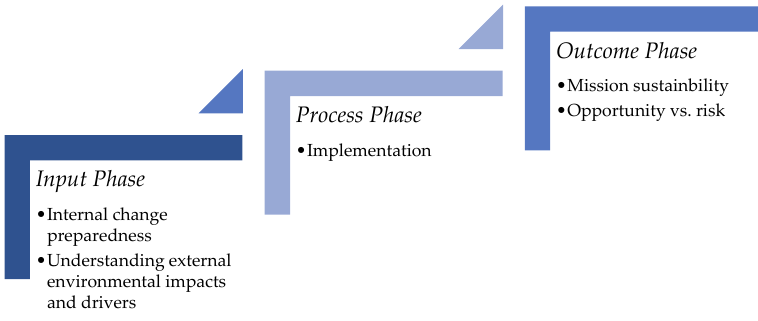
Figure 1. NDIS Implementation Framework—The High-Level Context.